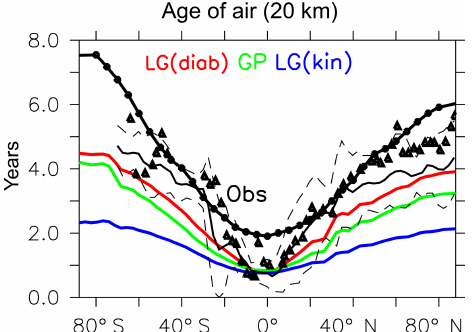
Figure 7. Zonal mean AoA at 20km of height ( ∼ 50hPa) from the SF 6 _AoA tracer (red: LG(diab), green: GP, blue: LG(kin)) as a mean over the years 2000–2010. Thick black line with circles: MI- PAS data as a mean over the years 2003, 2007, 2008, 2009, 2010, and 2011. Triangles: AoA from SF 6 at 20km; from Waugh and Hall (2002). Thin black dashed lines: minimum and maximum AoA from CO 2 at 20km; from Andrews et al.